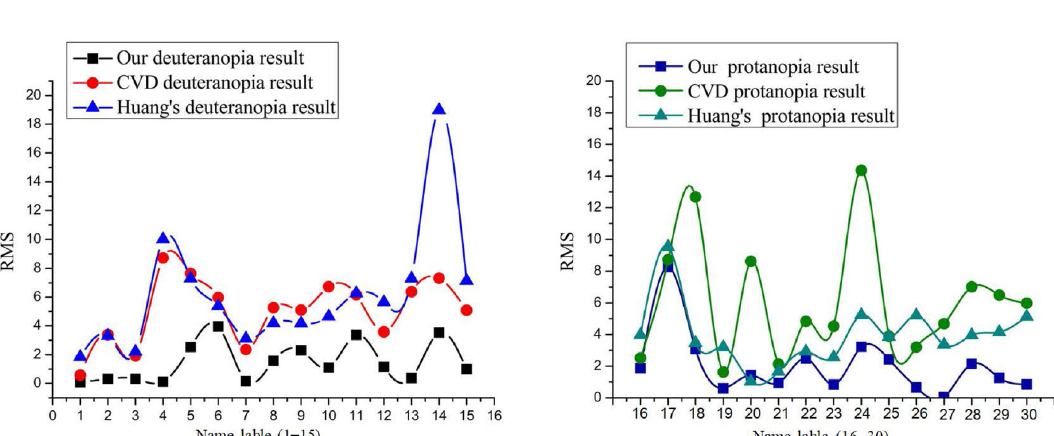
Fig. 11 Comparison of RMS values for our method and CVD simulation image, and Huang’s color correction method. Left: deuteranopia image, right: protanopia